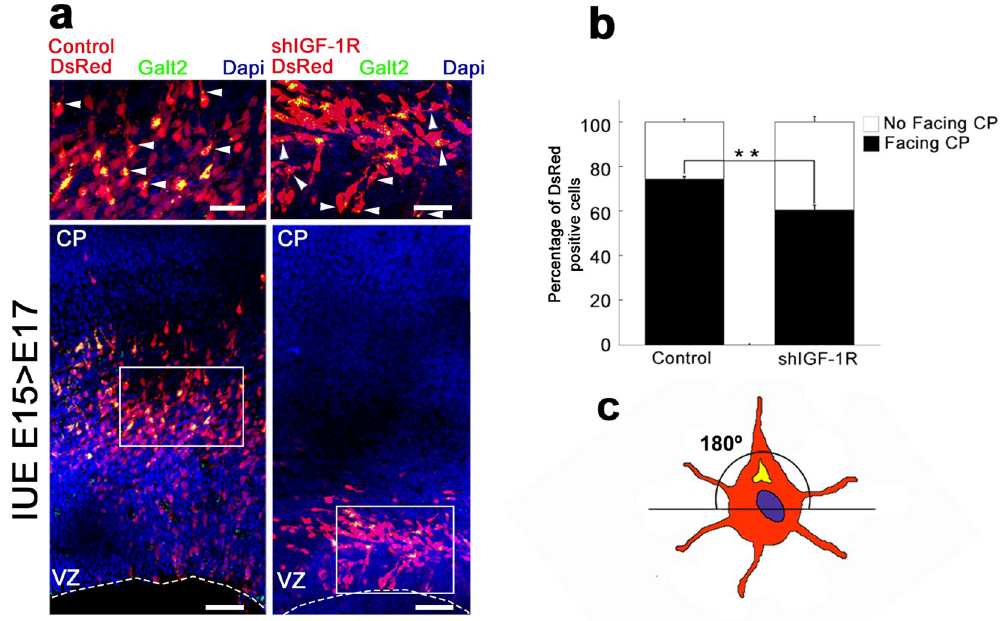
bar = 50 μ m (bottom) or 25 μ m (top). ( b ) Quantification of the experiment shown in A. Student’s t test; ** p-value = 0.01. Note that in the brains suppressed for IGF-1R the number of cells facing the cortical plate is close to 60% (random distribution = 50%). n = 3 independent experiments. An average of 300 cells was scored for each condition. ( c ) For quantifications, we considered that a cell has the Golgi not oriented to the CP when the majority of the GalT2 staining was concentrated below the